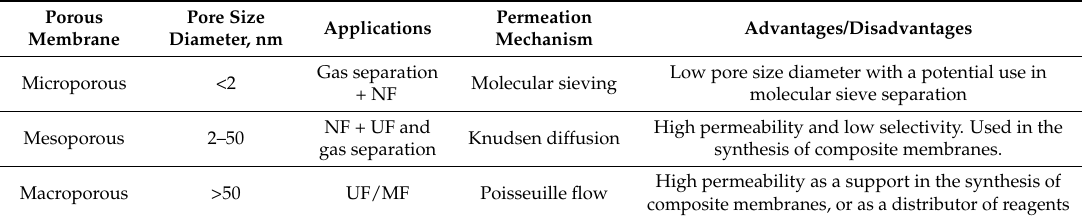
Table 2. Types of ceramic membranes based on their pore size and permeation mechanism [49].